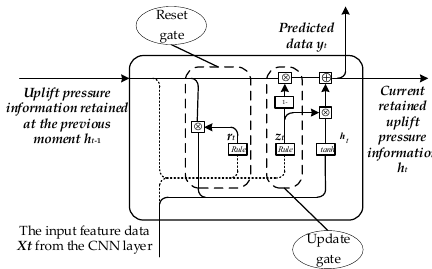
Figure 3. The internal structure of GRU unit.